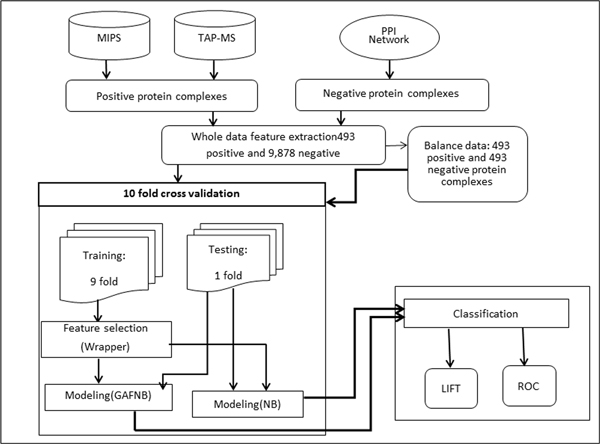
Flowchart of GAFNB evaluation.